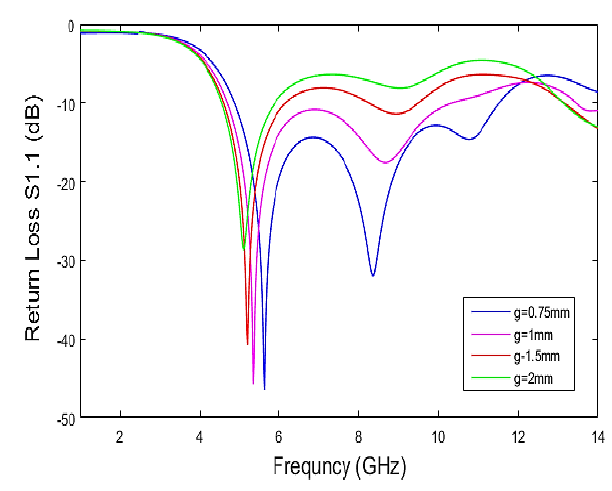
Figure 6: Simulated return loss S1.1 for different values of gap